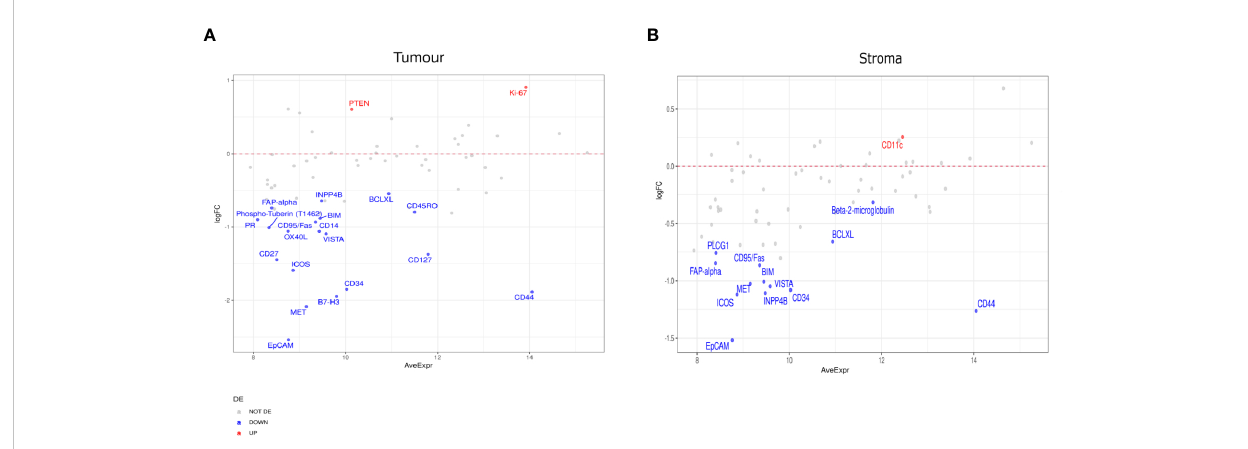
FIGURE 6 Differential protein expression between patients with partial response (PR) (n=5) and stable disease (SD) (n=3). (A, B) MA plots of Mean Expression (AveExpr) vs fold change (logFC) visualizing expression of protein biomarkers in patients with PR compared to patients with SD for (A) tumor samples or (B) stromal samples. Colors denote not differentially expressed markers (gray), signi fi cantly up- (red) and down-regulated (blue) markers based on false discovery rate (FDR) < 0.05 after multiple comparison